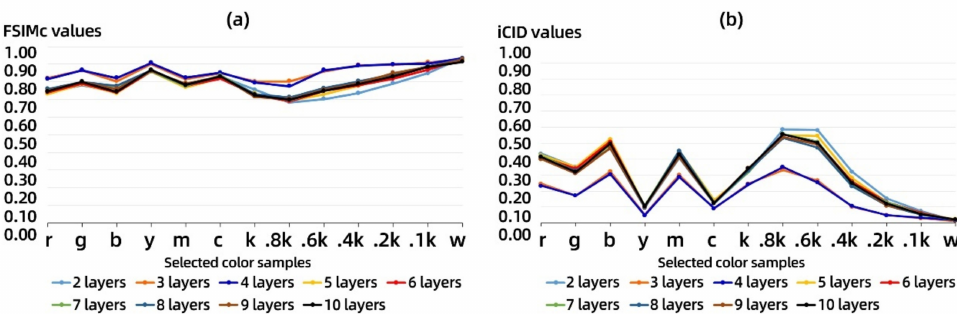
Figure 4. The average value of image-based metrics of test sample: ( a ) distribution of the feature similarity index measure of color image (FSIMc) values for nine controlled combinations and ( b ) distribution of the improved color-image-difference (iCID) values for nine controlled combinations.